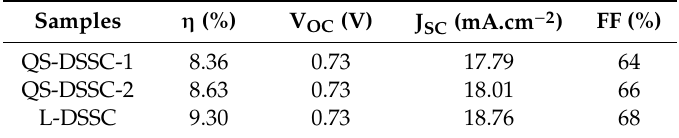
Table 3. Photovoltaic parameters of the DSSCs with electrospun PVDF membrane electrolytes and ionic liquid electrolytes.